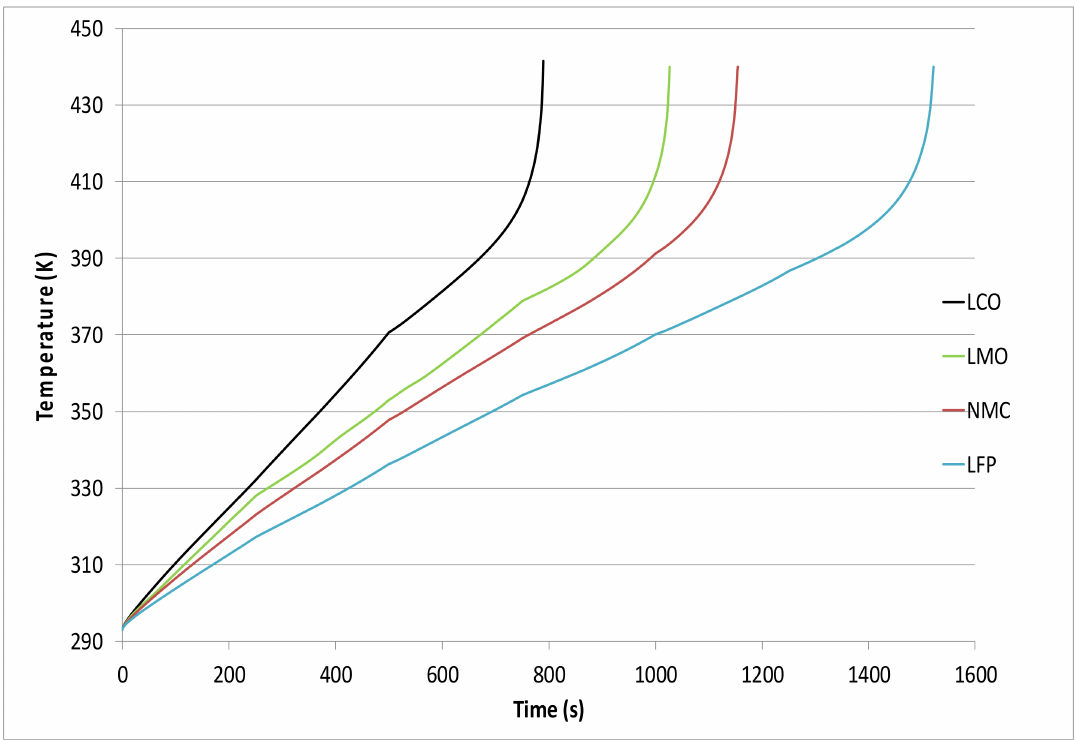
Figure 17. Temperature profile as a function of time for a cell exposed to an external thermal runaway (Tex = 420 K; h = 7.5 W/m 2